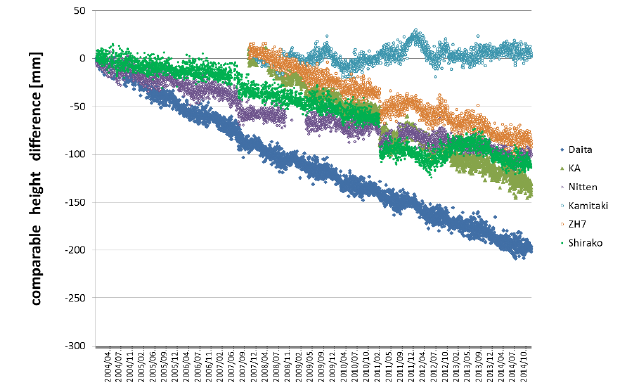
Figure 2. GPS observation result.